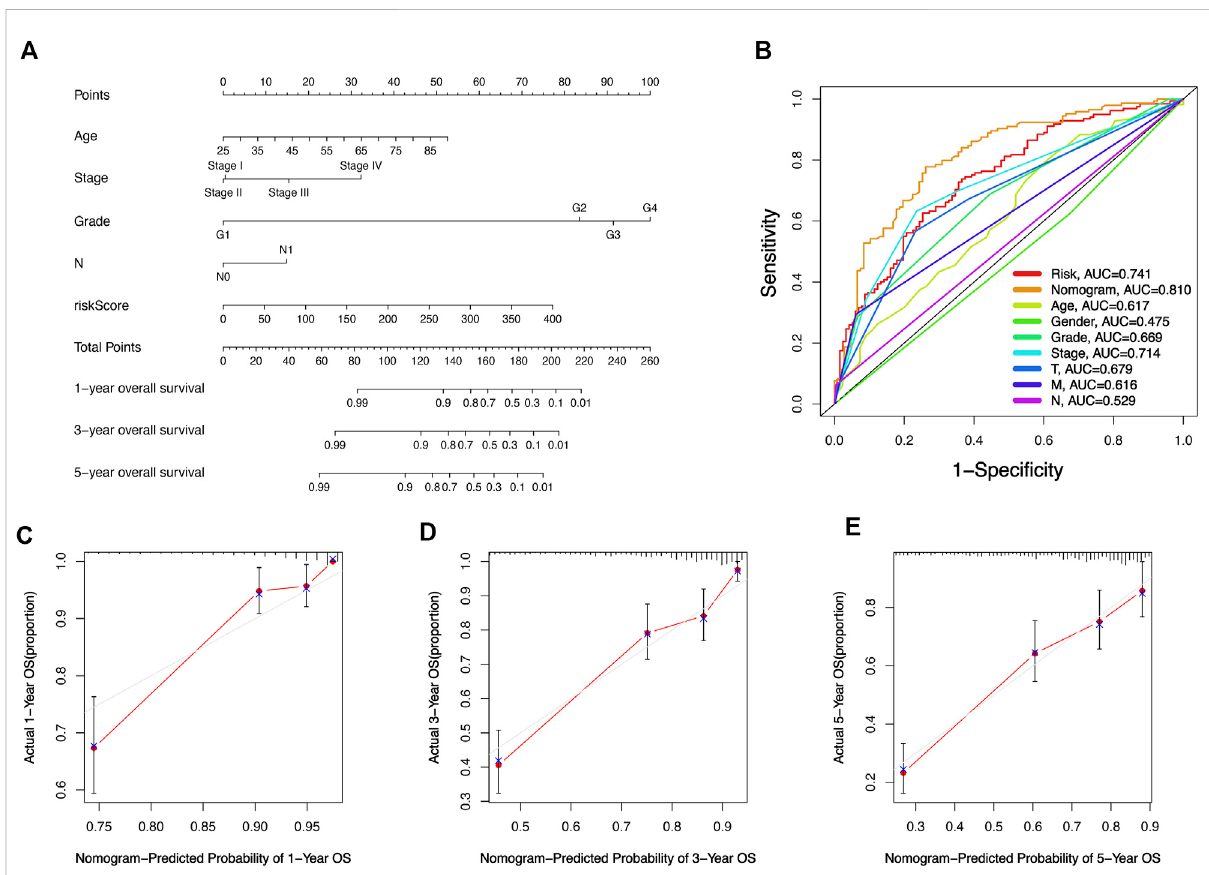
FIGURE 7 Establishment and validation of aNomogram to quantitatively predictthe prognosis of KIRC patients. (A) Nomogram to quantitatively predict 1, 3, and 5-year overall survival in KIRC patients. (B) ROC curves for Nomogram, risk scores, and Other clinical features. (C – E) The calibration chart shows that the Nomogram has a pretty predictive